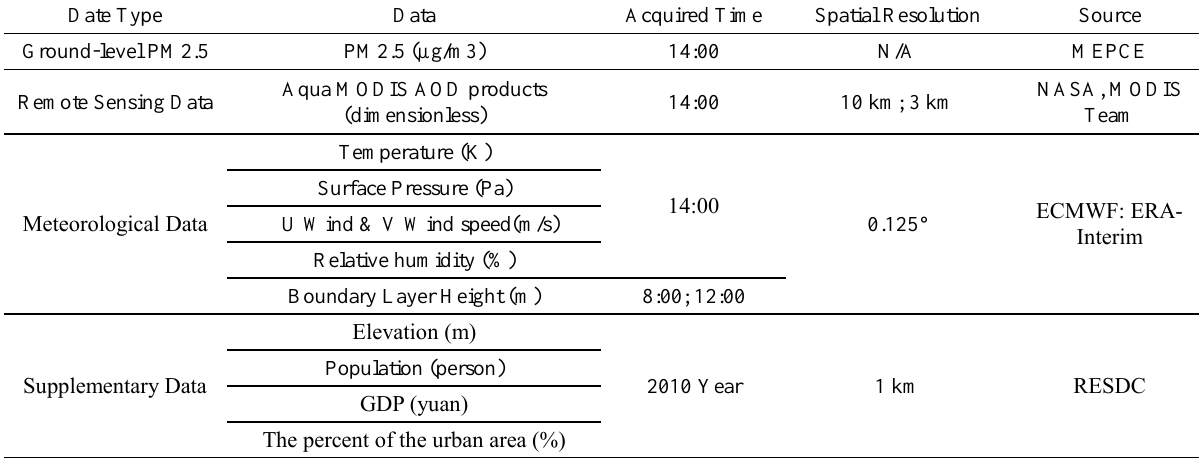
Table 1. Data sets used in this study.